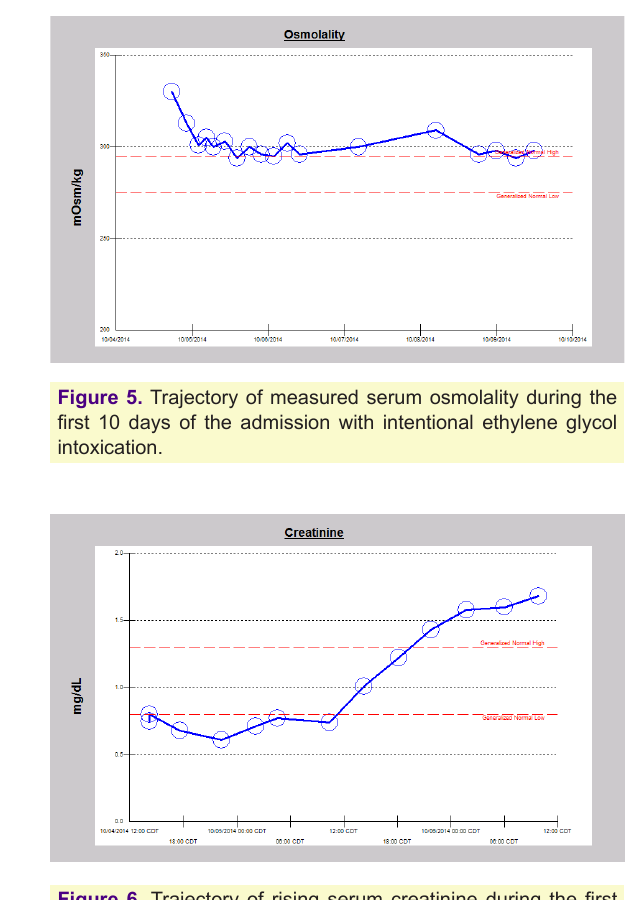
Figure 6. Trajectory of rising serum creatinine during the first 48 hours of the admission with intentional ethylene glycol